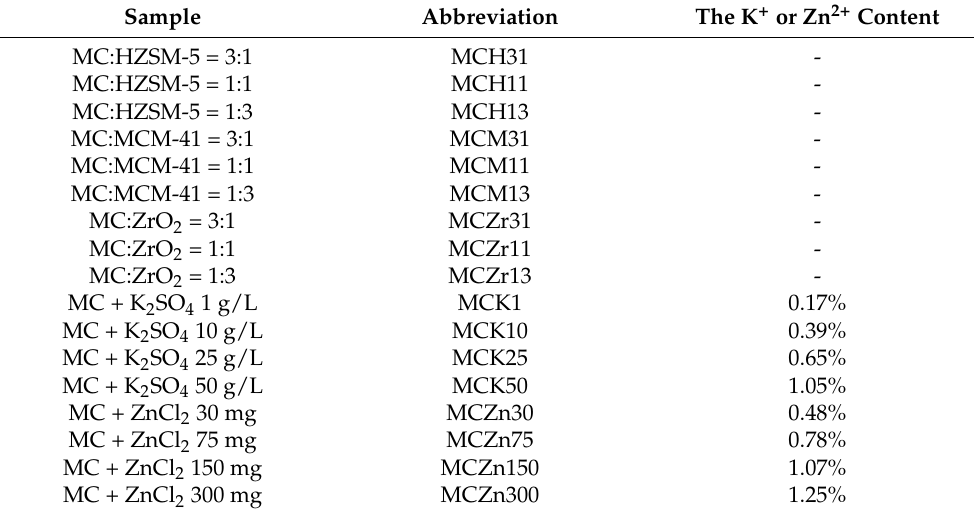
Table 3. Sample abbreviations and metal ion